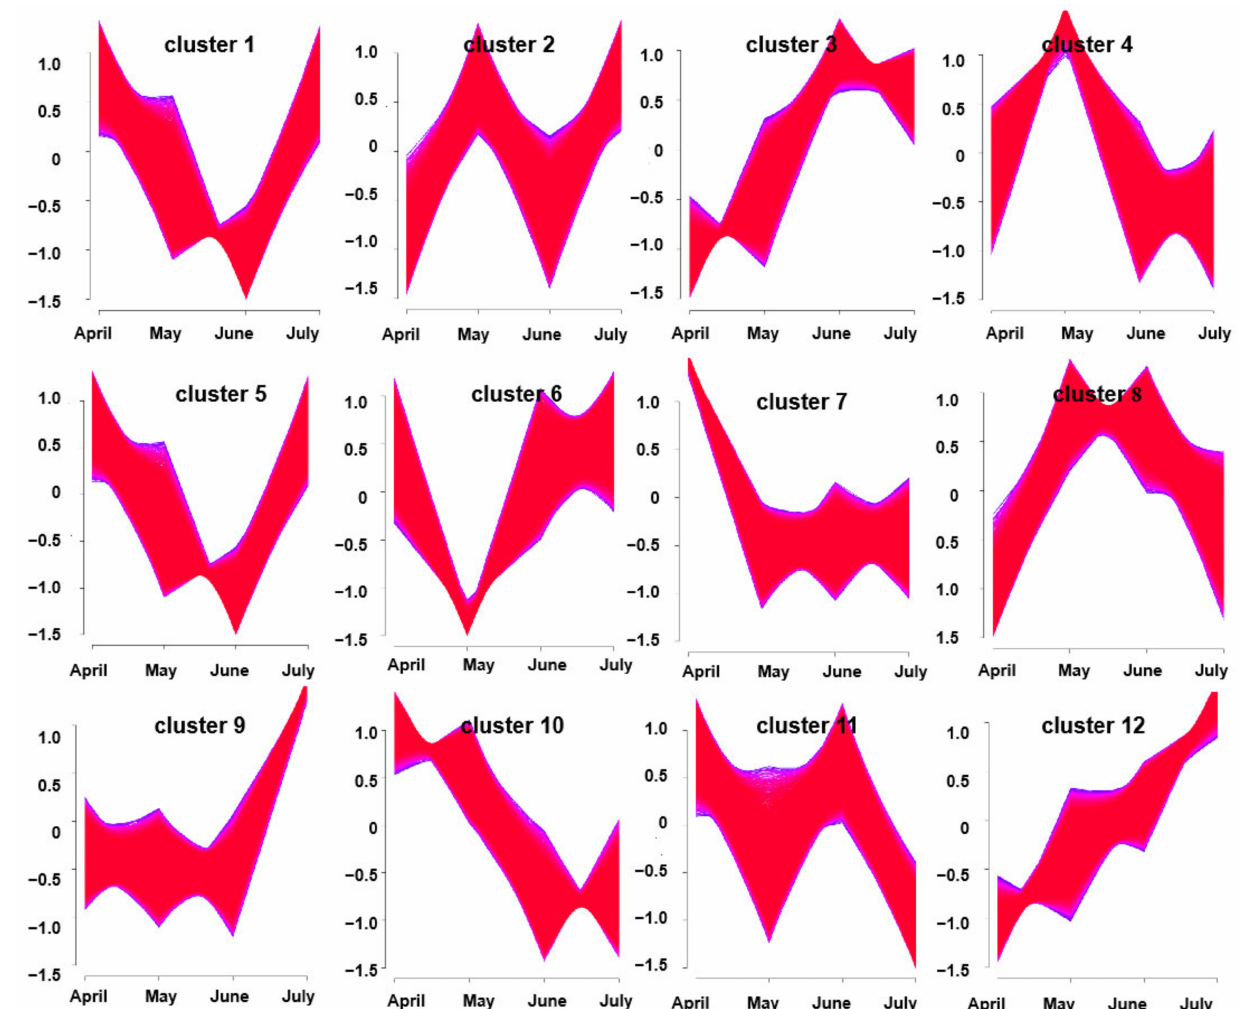
Figure 5. Clusters of DEGs obtained via soft clustering for A. argyi samples collected at four time